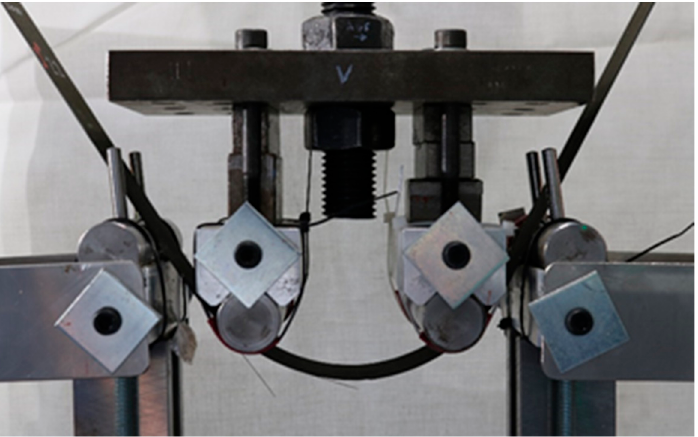
Figure 23. Specimen in four point bending test setup with maximum displacement of the upper supports [28].